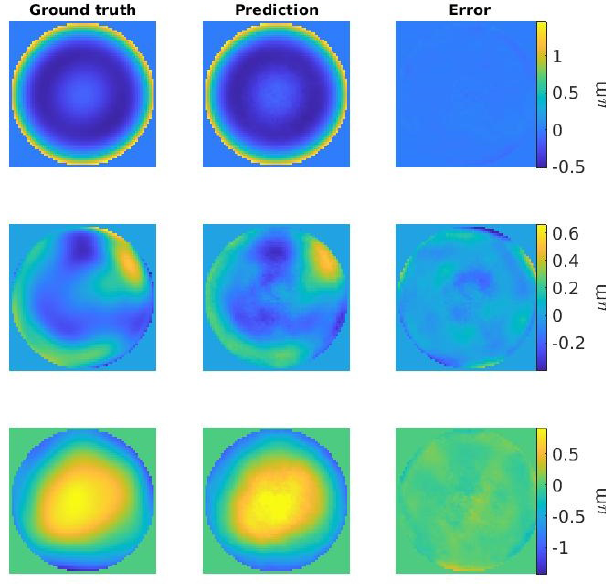
Figure 7. Three examples of predicted test difference topographies. The errors in the third column show the differences between the ground truth and the prediction. The root mean squared errors, from top to bottom, are 16, 84, and